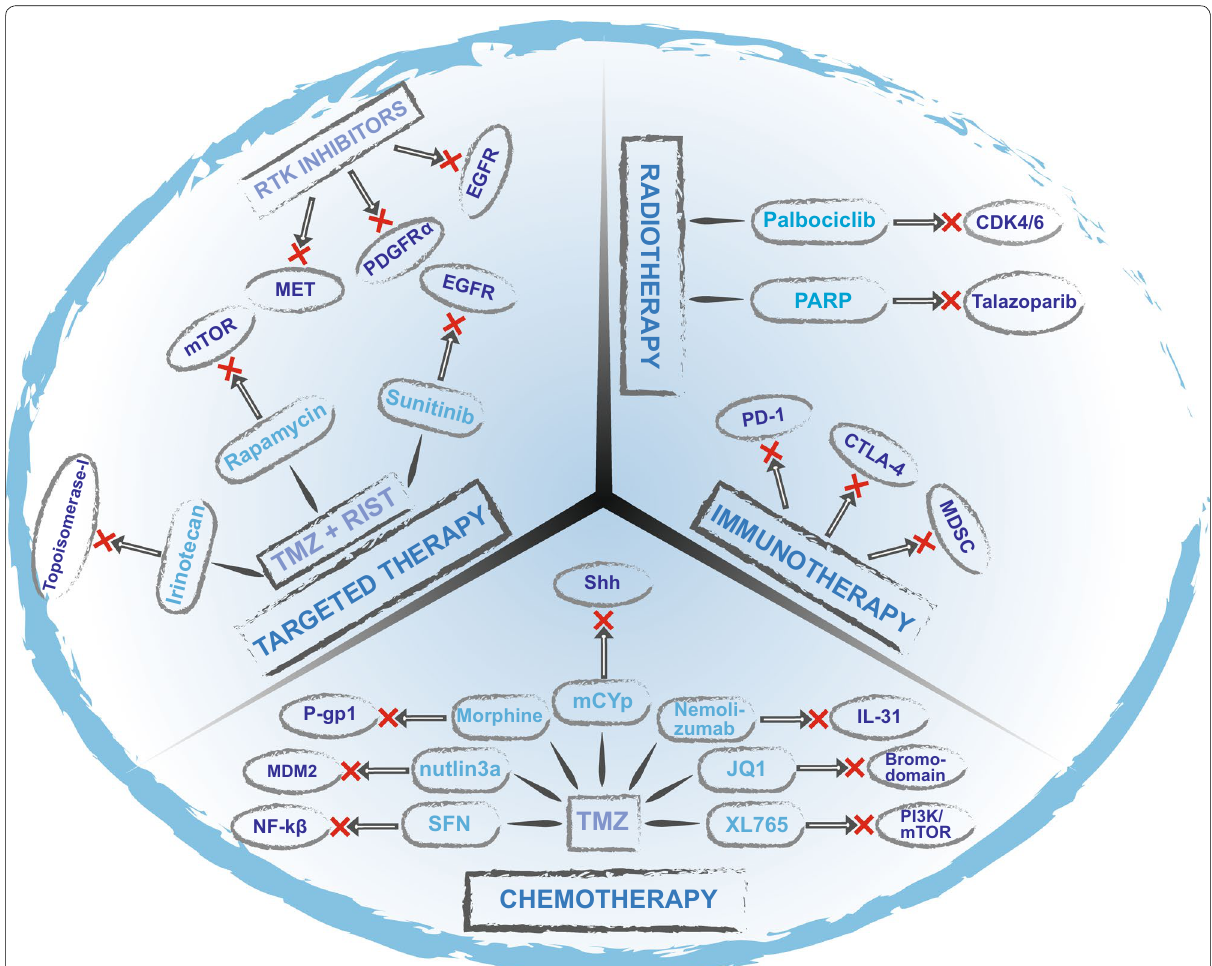
Fig. 1 Schematic representation of combination therapy in treatment of GBM. Targeted therapy approaches have the potential to improve patient outcome in the treatment of Glioblastoma. Small-molecule inhibitors in combination with chemo/radiotherapy can overcome chemo/ radioresistance in patients improving treatment efficacy when compared to monotherapy. We summarize small molecule inhibitors and their gene targets that are in preclinical development for GBM therapy and are being tested in combination with radio- and/or